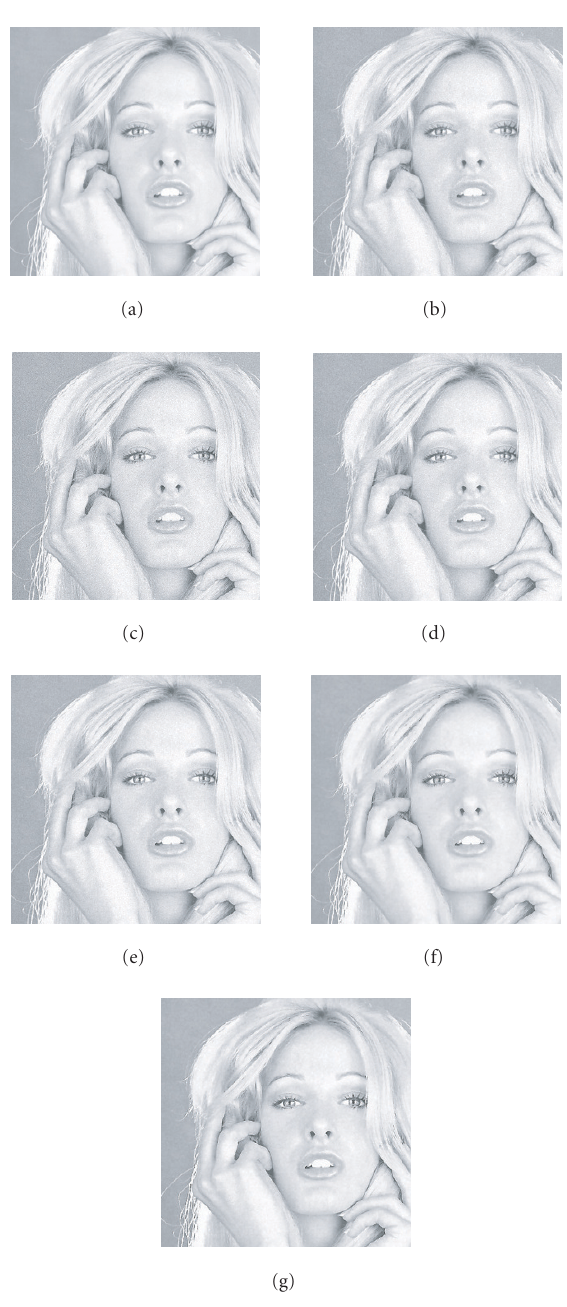
Figure 4: (a) Original image, (b) noisy image, (c) results given by linear UM, (d) WM UM, (e) PWM-UM, (f) FAB anisotropic di ff u- sion, and (g) proposed